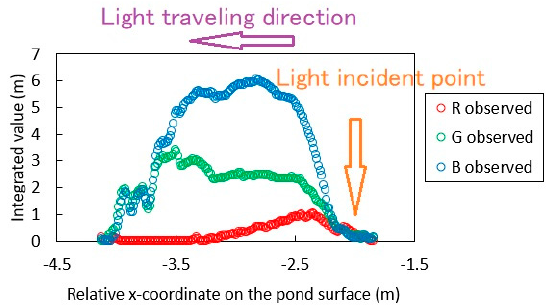
Figure 18. Displays of integrated RGB data for image analyses. The x-coordinate on the horizontal axis was depicted in the relative coordinate